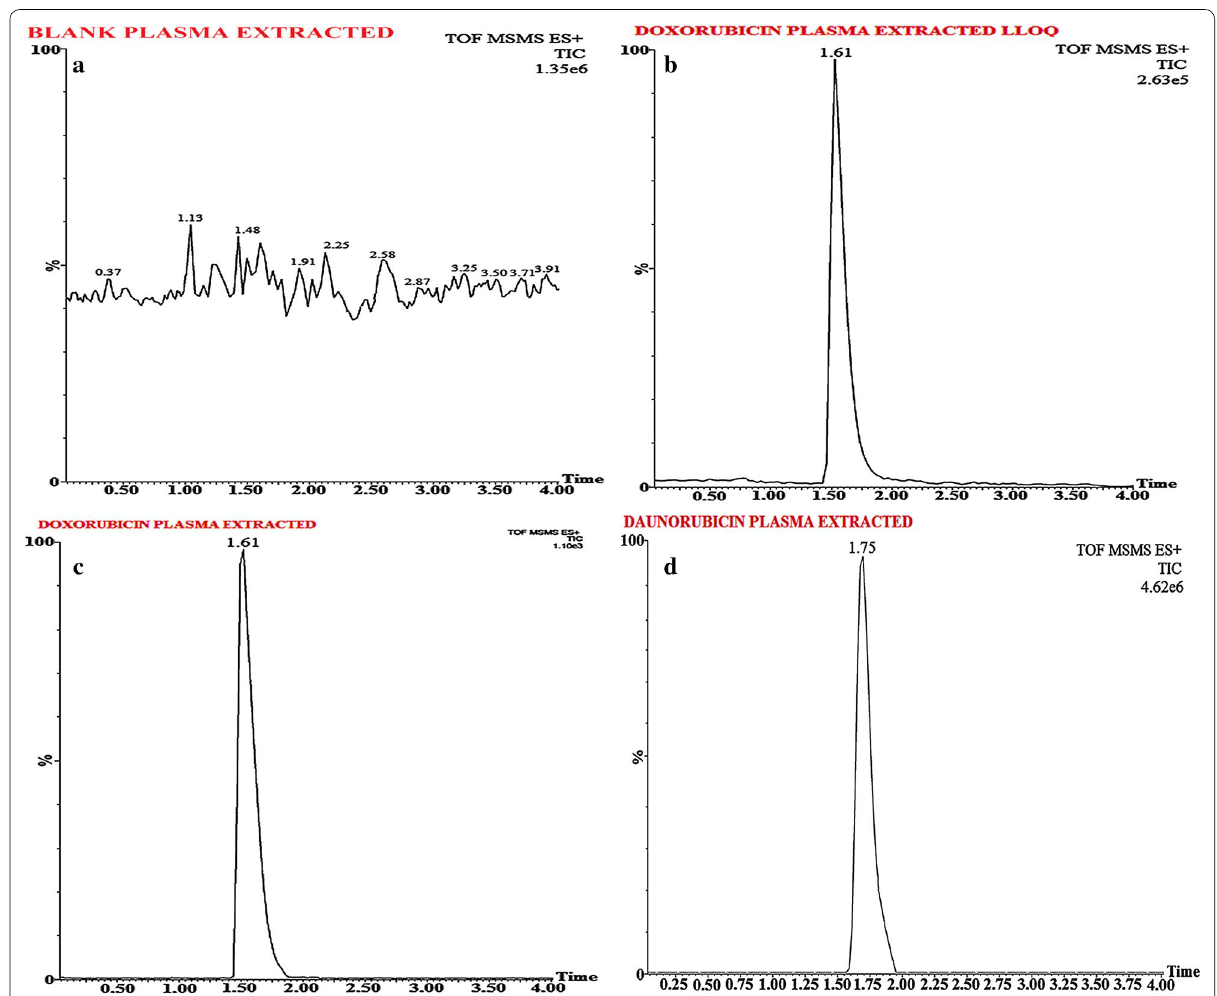
Fig. 6 Typical chromatograms of extracted blank plasma ( a ), Plasma extracted doxorubicin (DOX) LLOQ ( b ), Plasma extracted doxorubicin (DOX) ( c ), and Plasma extracted daunorubicin ( d )